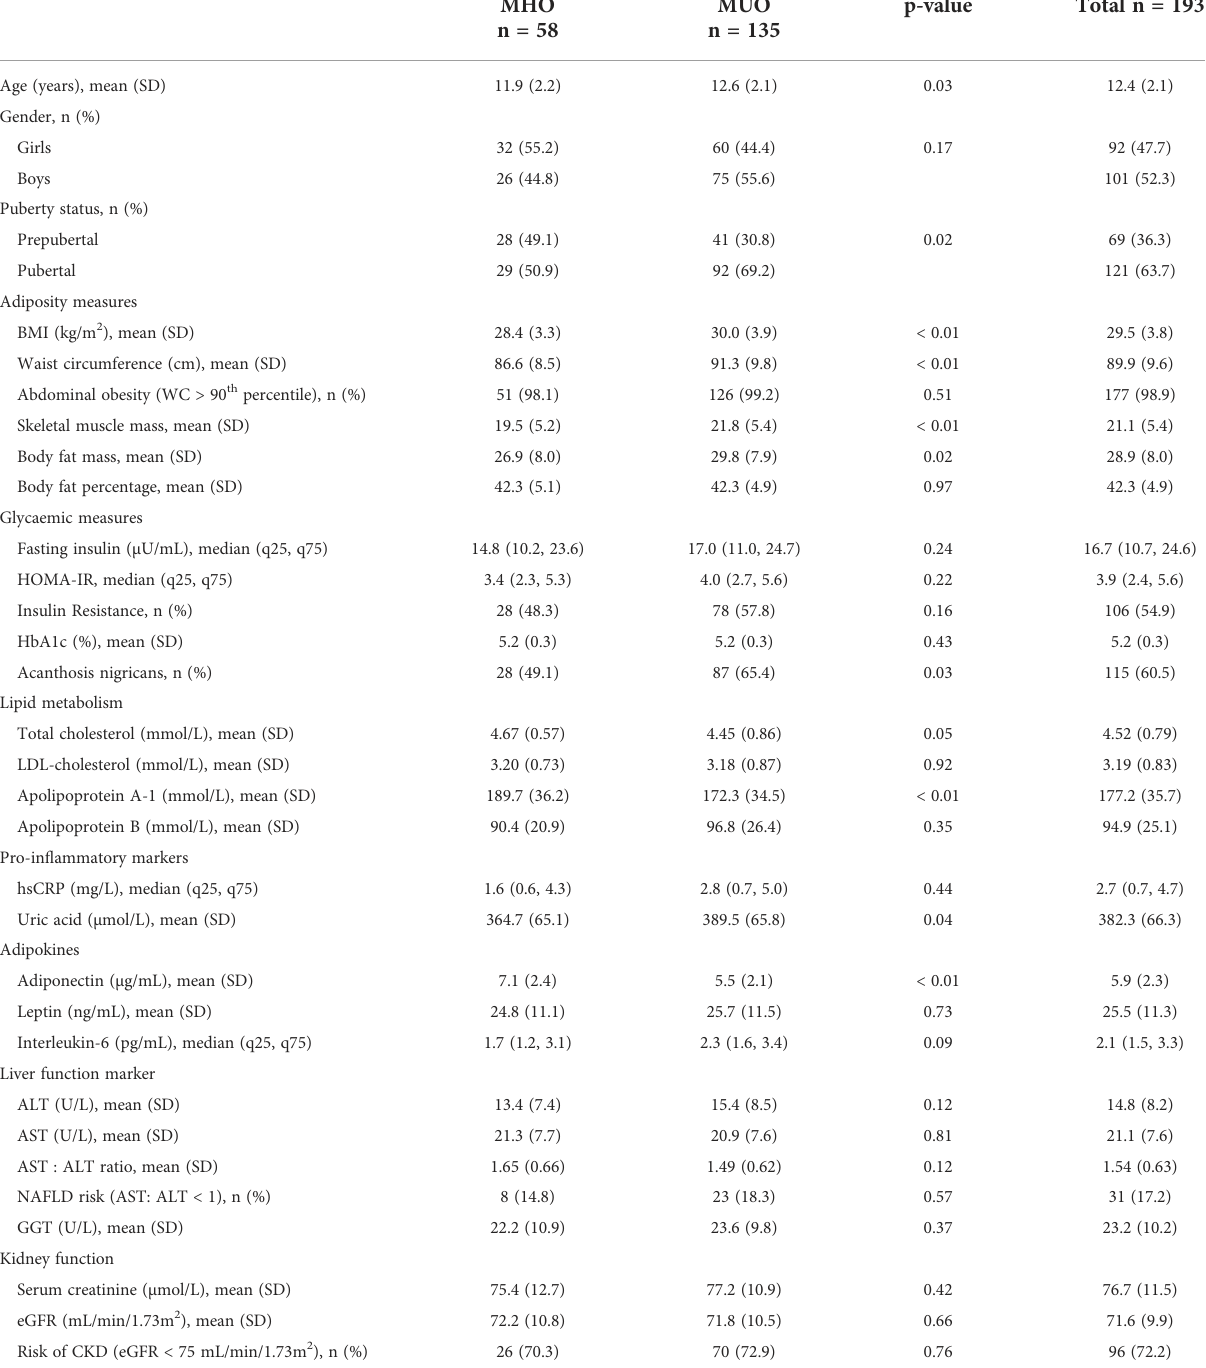
TABLE 3 Obesity-related clinical and laboratory parameters examined in MHO and MUO